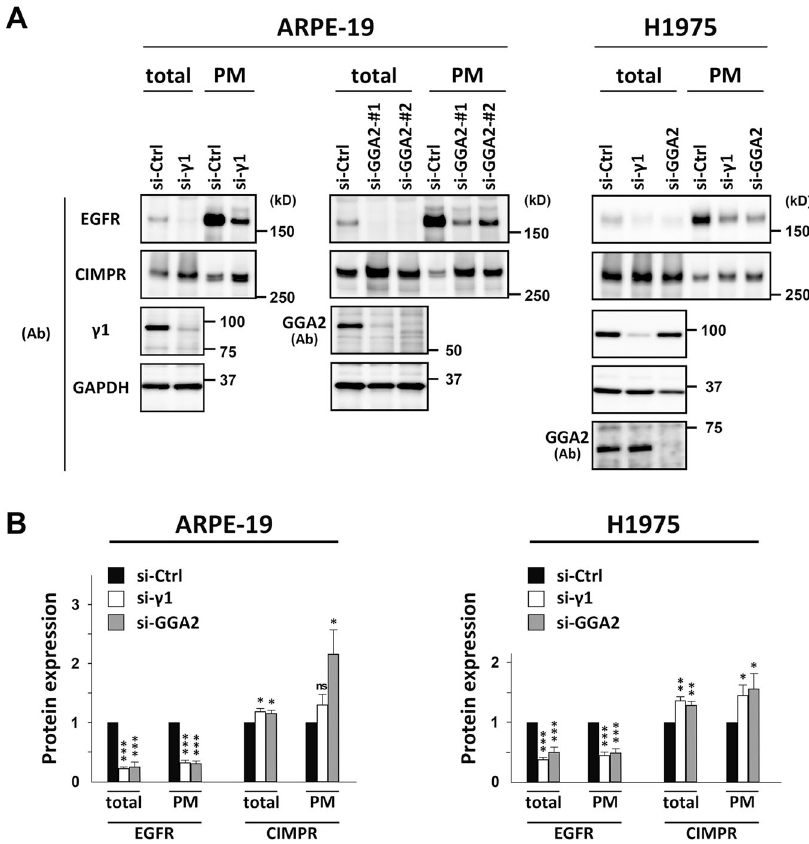
Fig. 3 Depletion of AP-1 or GGA2 downregulates cell surface expression of EGFR. A Western blotting of ARPE-19 and H1975 cells transfected with si-Ctrl, si- γ 1, or siRNA for GGA2 (si-GGA2-#1 or -#2). After biotinylation of surface proteins, lysates of the transfectants (total) and the PM fraction (PM) were analyzed using the antibodies (Ab) against EGFR, CIMPR, γ 1-adaptin ( γ 1), GGA2, and GAPDH. Ten percent of the input was applied in the total lane. B The ratio of si- γ 1 or si-GGA2#2 to si-Ctrl was plotted as the mean ± SD (of three and four experiments for ARPE-19 and H1975, respectively). Statistical differences between each siRNA and si-Ctrl were analyzed using Student ’ s t -test (* P < 0.05, ** P < 0.01, and *** P < 0.001, ns: not signi fi